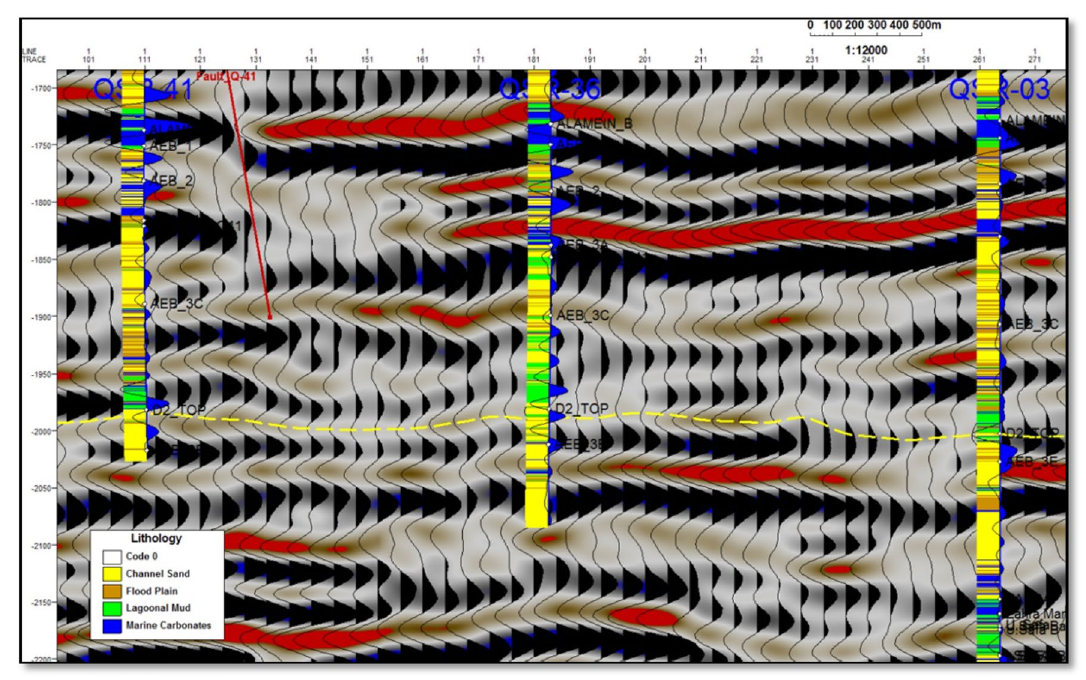
Fig. 13 E–W seismic section along wells Qasr-41–36–03. Lithology and synthetic positive amplitude (blue) are displayed in each well. Ampli- tude wiggles are displayed (black wiggles are positive amplitudes). Top D2 sand unit in dashed yellow line